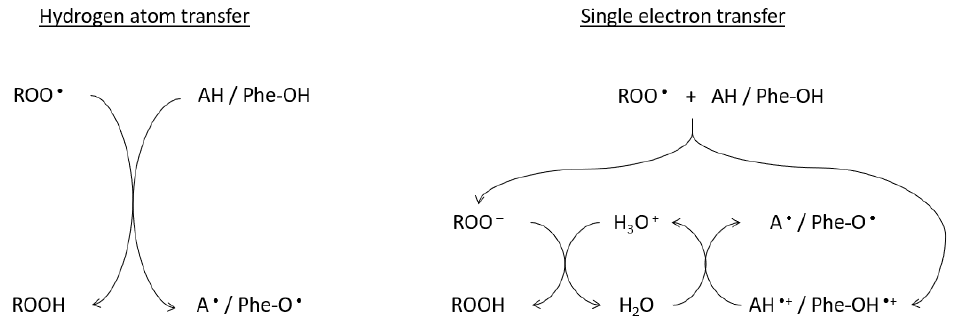
Figure 2. Quenching mechanisms of target radicals by hydrogen atom transfer and/or single electron transfer. AH — antioxidant; A • — antioxidant radical; Phe-O • — aryloxy radical; Phe-OH — phenolic compound; ROO • — target radical.